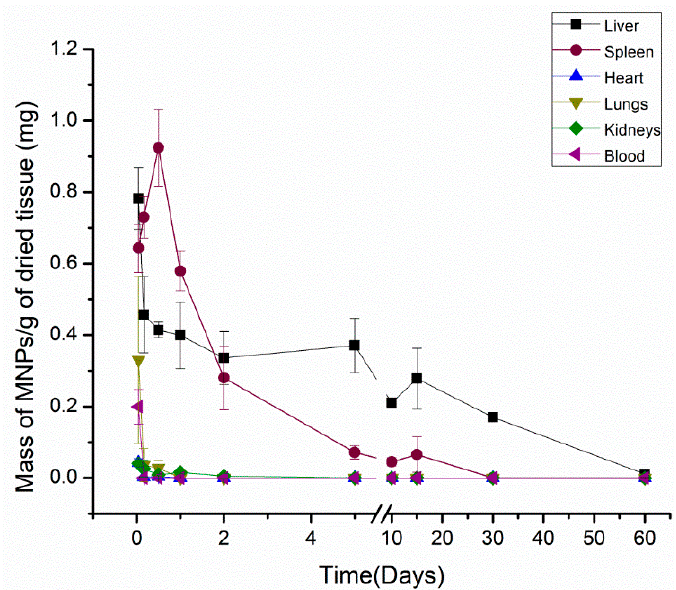
Figure 3. Biodistribution results for all organs of interest of the citrate ‐ coated MNPs over the period evaluated.